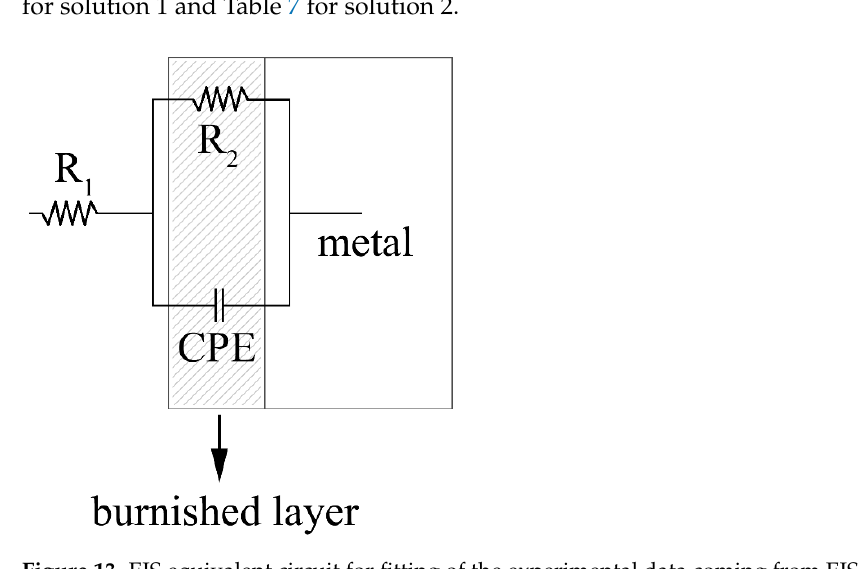
Figure 13. EIS equivalent circuit for fitting of the experimental data coming from EIS tests.